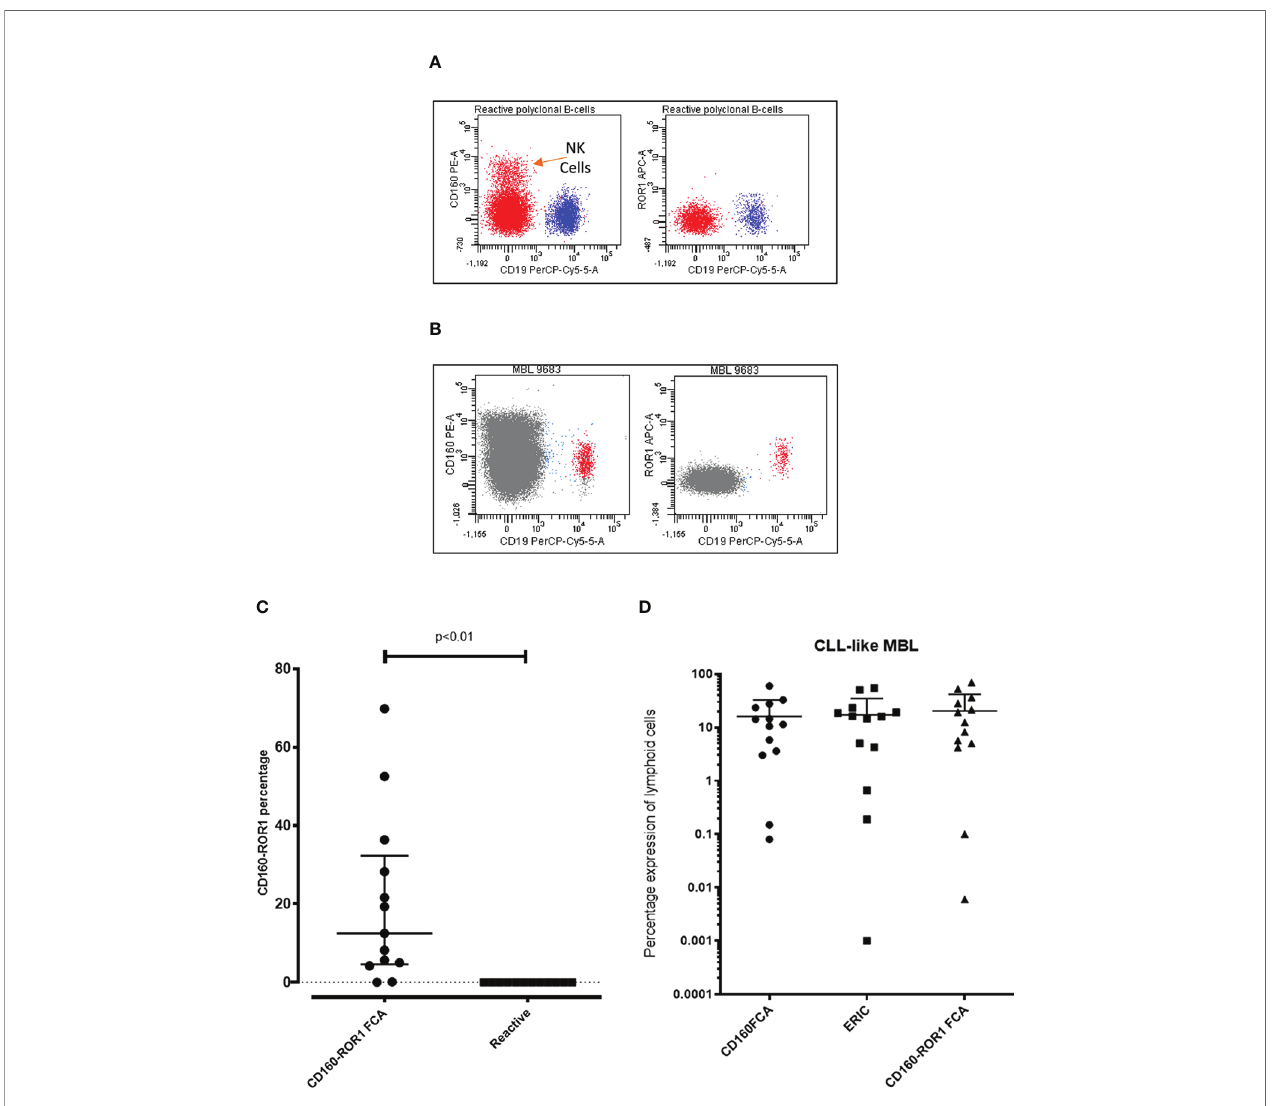
FIGURE 5 | Assessment of ROR1 and CD160 in Monoclonal B-cell lymphocytosis. Patient samples with monoclonal B-cell lymphocytosis (MBL, n = 13) were simultaneously assessed by CD160FCA, the ERIC protocol and CD160-ROR1FCA. (A) Dot plot demonstrating CD160 and ROR-1 negativity on polyclonal B-cells from a reactive case. (B) Dot plot demonstrating CD160 and ROR-1 positivity on a case of monoclonal B-cell lymphocytosis. (C) CD160- ROR1FCA percentage expression in MBL versus samples with polyclonal B-cells ( “ Reactive ” , n = 13, p < 0.01). (D) Comparison of the three assays in CLL- like MBL (n =